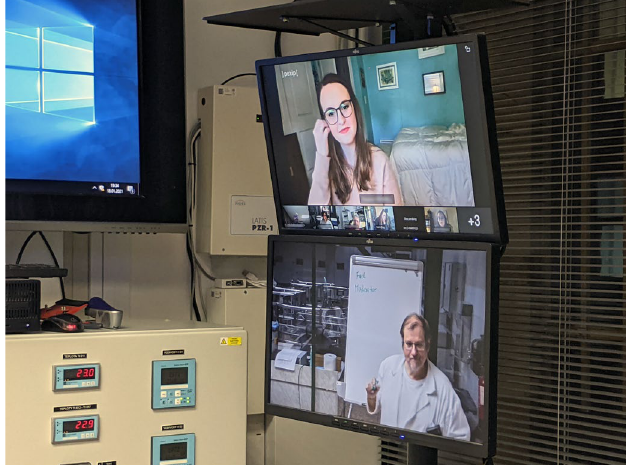
Fig. 13. Remote experimental education for students from the VR-1 Reactor to students from the Middlebury Institute of International Studies at Monterey, California, USA in January